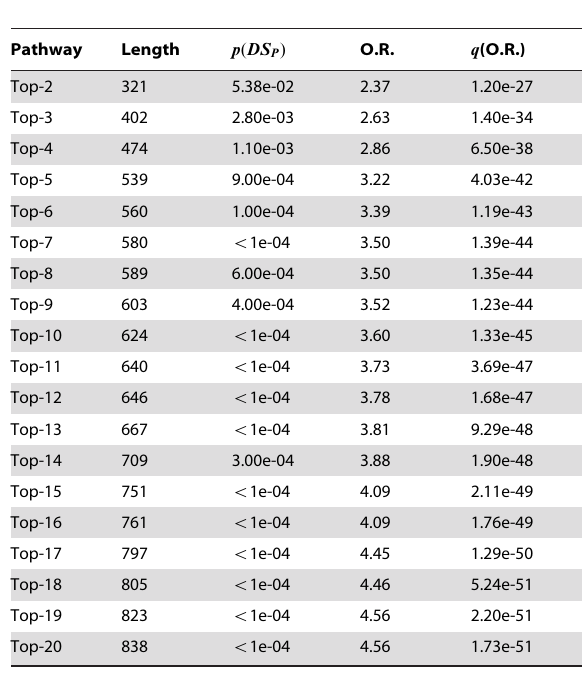
Table 5. PoDA results for sucessive unions of significant pathways in the liver cancer